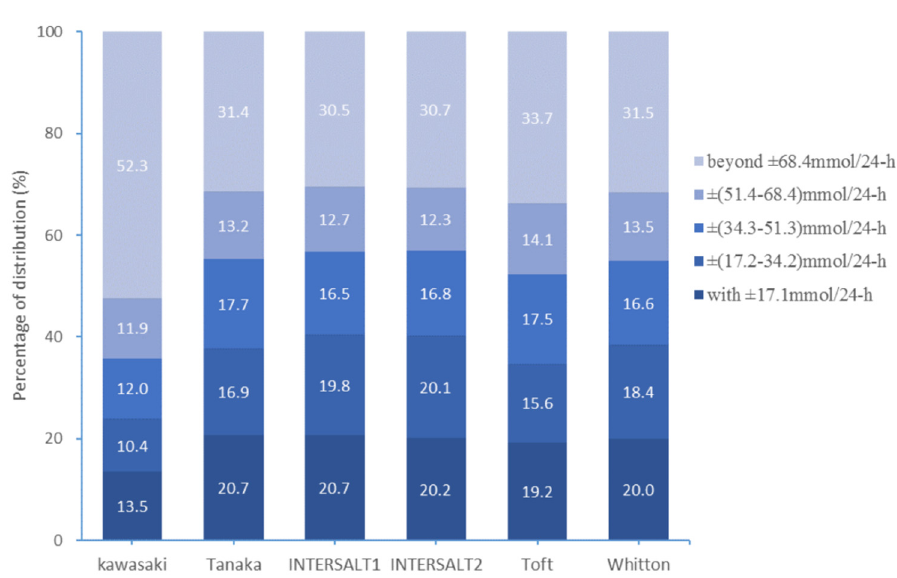
Figure 3. Absolute difference distributions of measured and predicted 24-hUNa excretion.